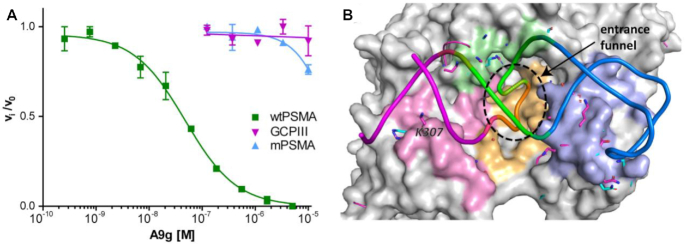
Comparison of A9g binding to human PSMA, GCPIII and mouse PSMA (mPSMA). (A) Enzymatic activity of purified human wtPSMA, mPSMA and GCPIII was determined in the presence of increasing concentrations of A9g using [3H]NAAG as a substrate. Experiments were done in duplicate and experimental points are plotted as means ± standard error. (B) Comparison of A9g-binding interfaces of PSMA, GCPIII and mPSMA. The three PSMA homologues were superposed on corresponding Cα atoms, human PSMA is shown in surface representation (gray) with all amino acids within 5 Å from A9g (color-coded ribbon: magenta S1 stem, orange L1 loop, green S2 stem, blue L2 loop) colored according to regions of A9g with which they interact. Corresponding amino acids from GCPIII and mPSMA are shown as magenta and blue sticks, respectively, and only side chains bigger than the matching PSMA residues are visible projecting from the PSMA surface.